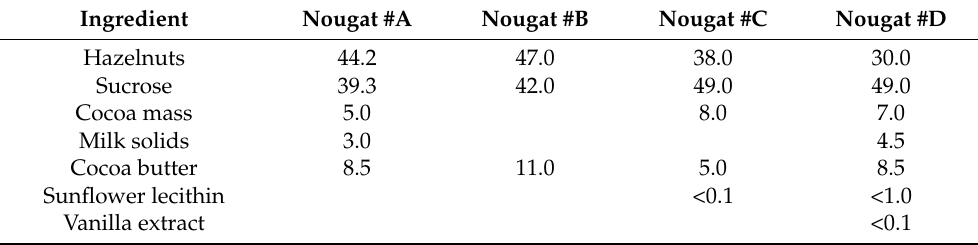
Table 1. Formulation of the nougat samples (g/100 g) used in this